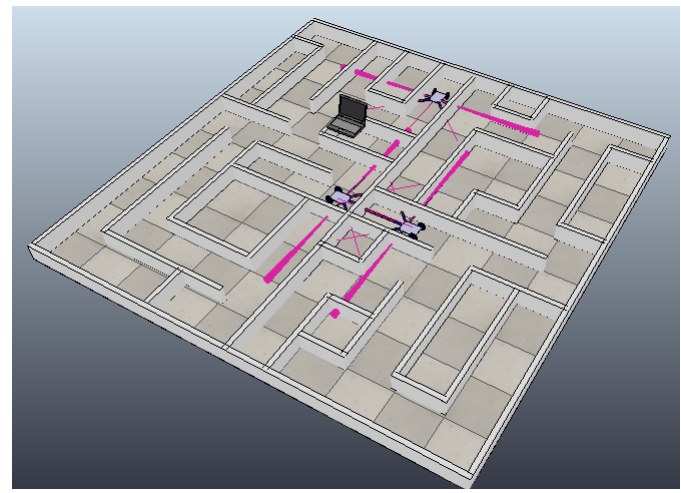
Figure 12. Experiment with three robotic agents and a monitor